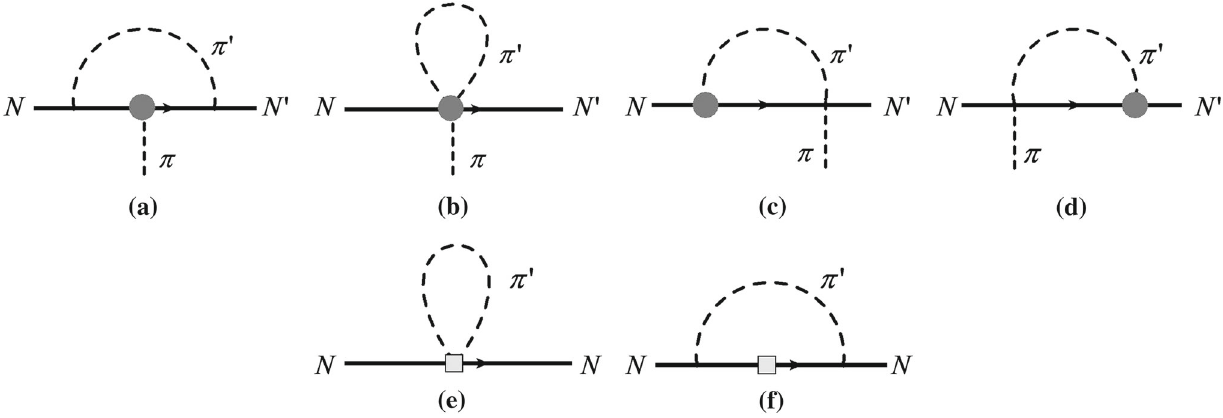
Fig. 1 1PI diagrams involved in the analysis of h 1 π − (δ m N ) 4 q matching relation at one